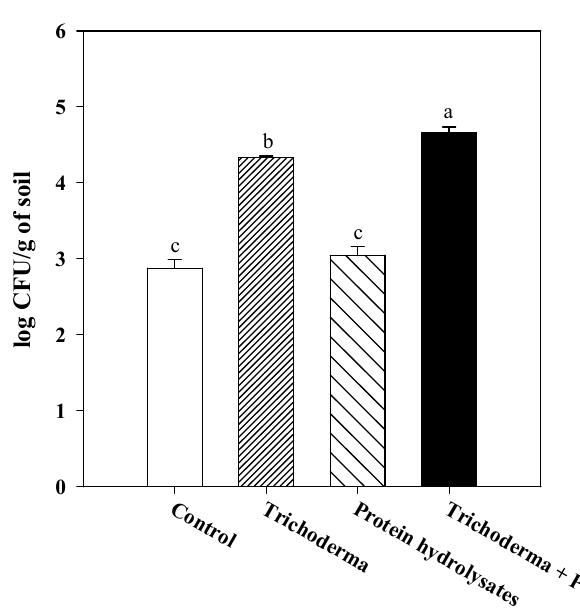
Figure 1. The number of Trichoderma colony forming units (CFU) at the end of the field experiment in soil samples collected in the wall rocket rhizosphere after treatments with Trichoderma and the protein hydrolysates (PH) biostimulant, singly and in combination. Values are significant at p ≤ 0.001, and values followed by different letters are significantly different according to Fisher test at p ≤ 0.05.